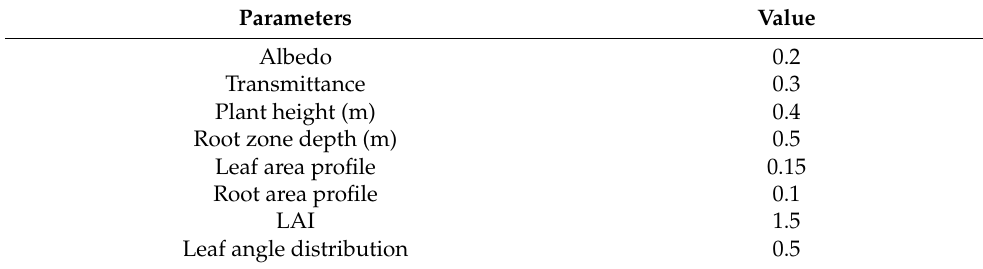
Table 2. Properties of Funkia (Hosta)